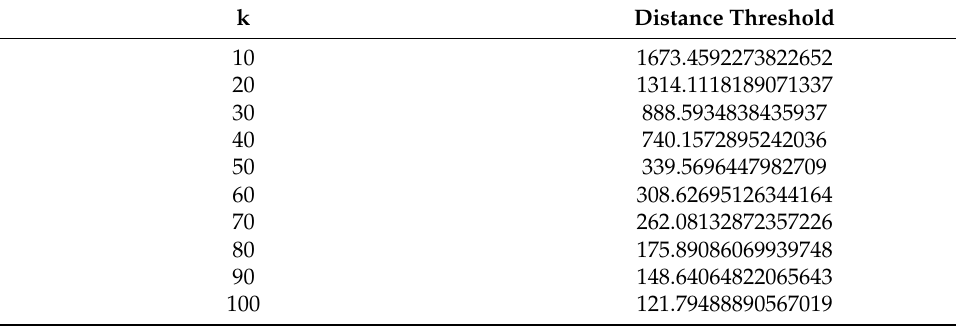
Table 2. Distance thresholds with setRuns() and setEpsilon() of the k-means